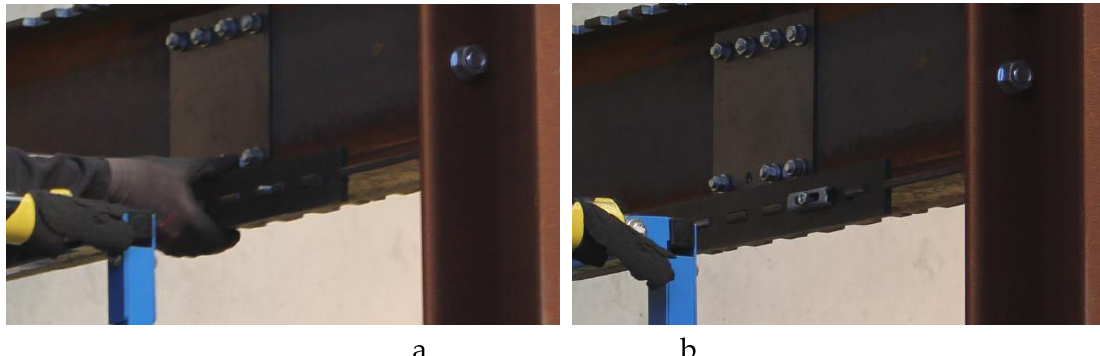
Figure 18. Installation of the side plates: ( a ) side plate inserted into the flange; ( b ) side place secured.